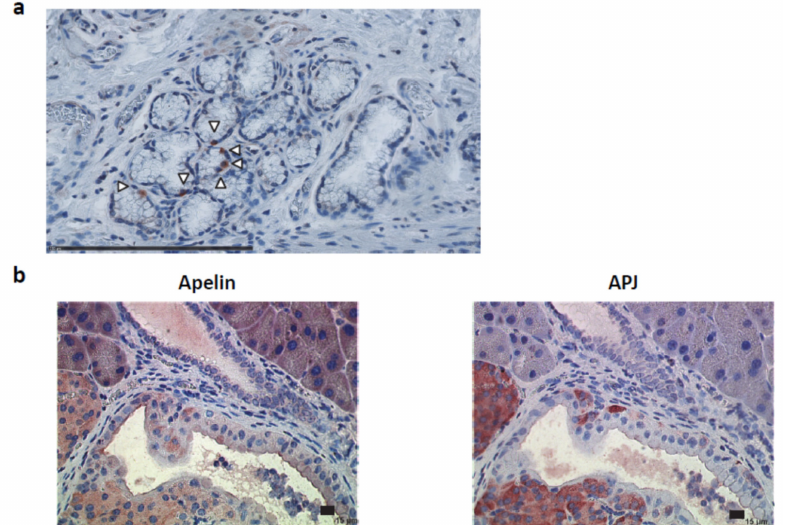
Figure A4. Expression of apelin and APJ in human and KPC mouse model PanIN lesions. ( a ) Apelin receptor is expressed in isolated cells which are tightly attached or scattered within the ductal epithelium of PanIN 1 lesions in human pancreatic ductal adenocarcinoma (open triangle). Scale bar, 250 µ m. Representative images from n = 3. ( b ) Immunohistochemistry realized on KPC mouse model using anti-apelin (left panel) or anti-APJ (right panel) antibodies. Scale bar, 15 µ m Representative images from n = 3.